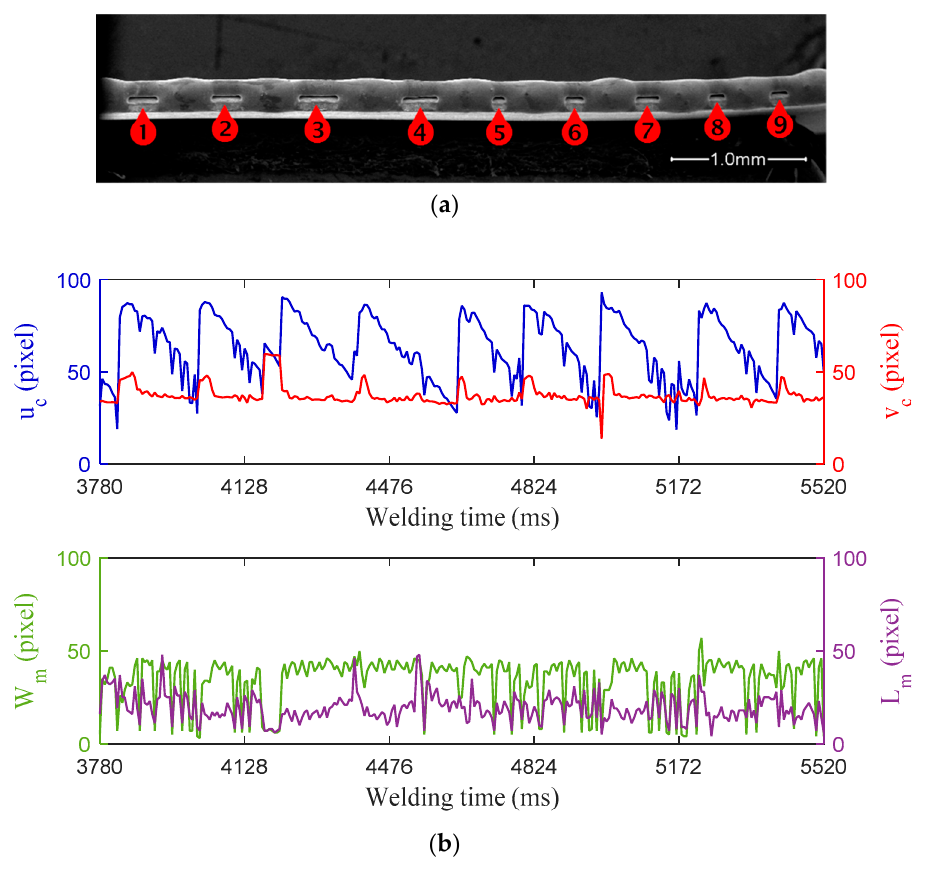
Figure 10. Experiment results with lack of fusion caused by weld misalignment: ( a ) Top-view of the edge weld profile observed under SEM with 50× magnification; ( b ) Characteristic parameters of weld pool monitored during MPAW.